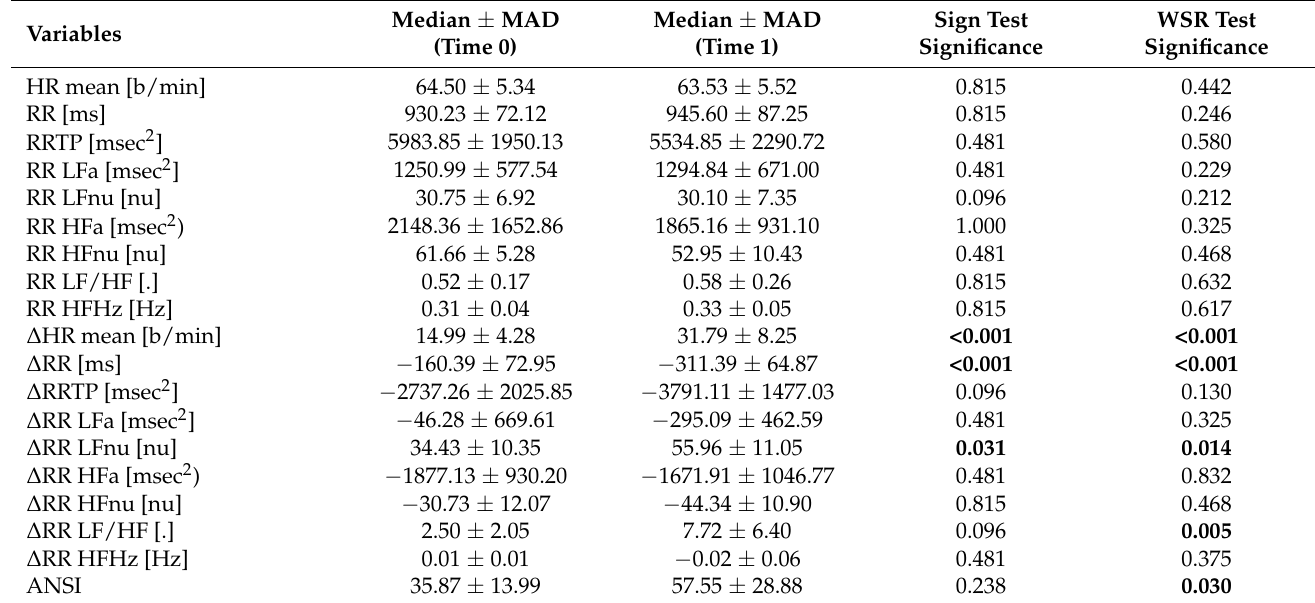
Table 2. Representative descriptive indices of RR interval variability indices at rest and their changes induced by active orthostatism: Summary statistics (median ± MAD at T0 and T1) and two-tailed non-parametric statistical